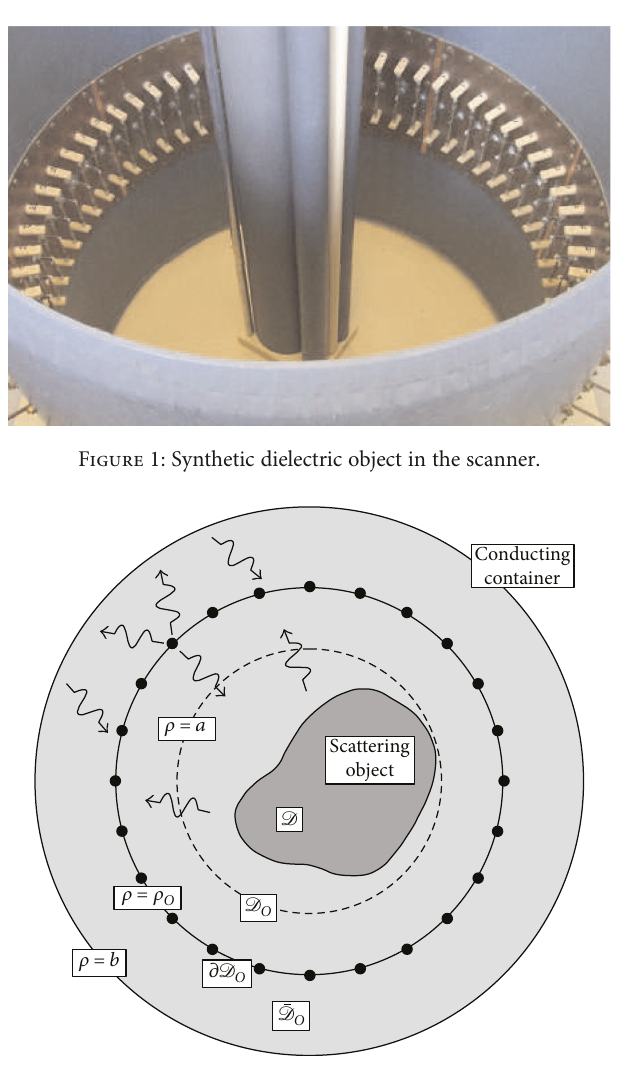
Figure 2: Two-dimensional model of object in